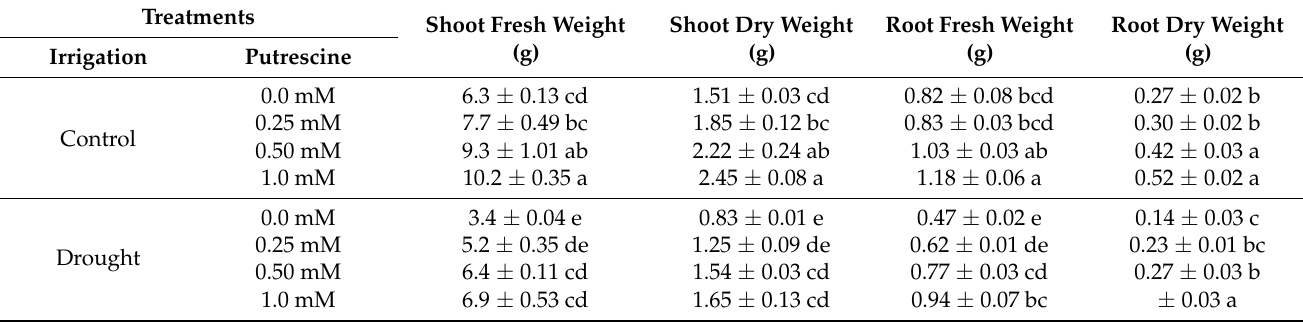
Table 2. The response of shoot and root weights of the wheat plant to putrescine, drought stress, and their combination. Values depict the mean and standard error. Different letters indicate different significance between